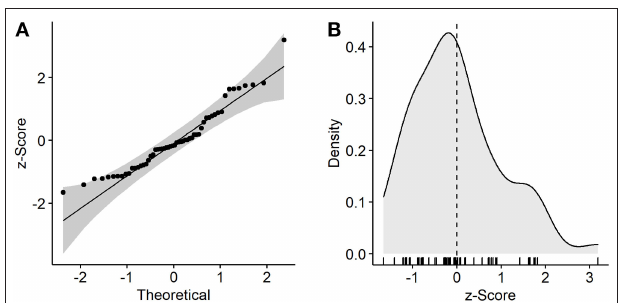
FIGURE 5 | Visual investigation of normal distribution of z-score transformed distances. (A) Observed z-scores were plotted against the theoretical distribution. The theoretical ideal normal distribution is indicated as straight line, while the gray shading indicates a confidence interval. (B) Density plot results in a bell shaped curve, indicating a normal distribution. Z-scores of individual observations are indicated by the rug. The dashed black line shows the mean of all